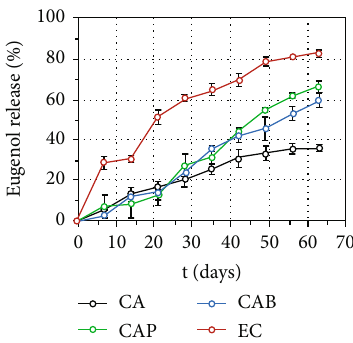
Figure 12: Eugenol release pro fi les of a CA, CAB, CAP, and EC eugenol-loaded microspheres